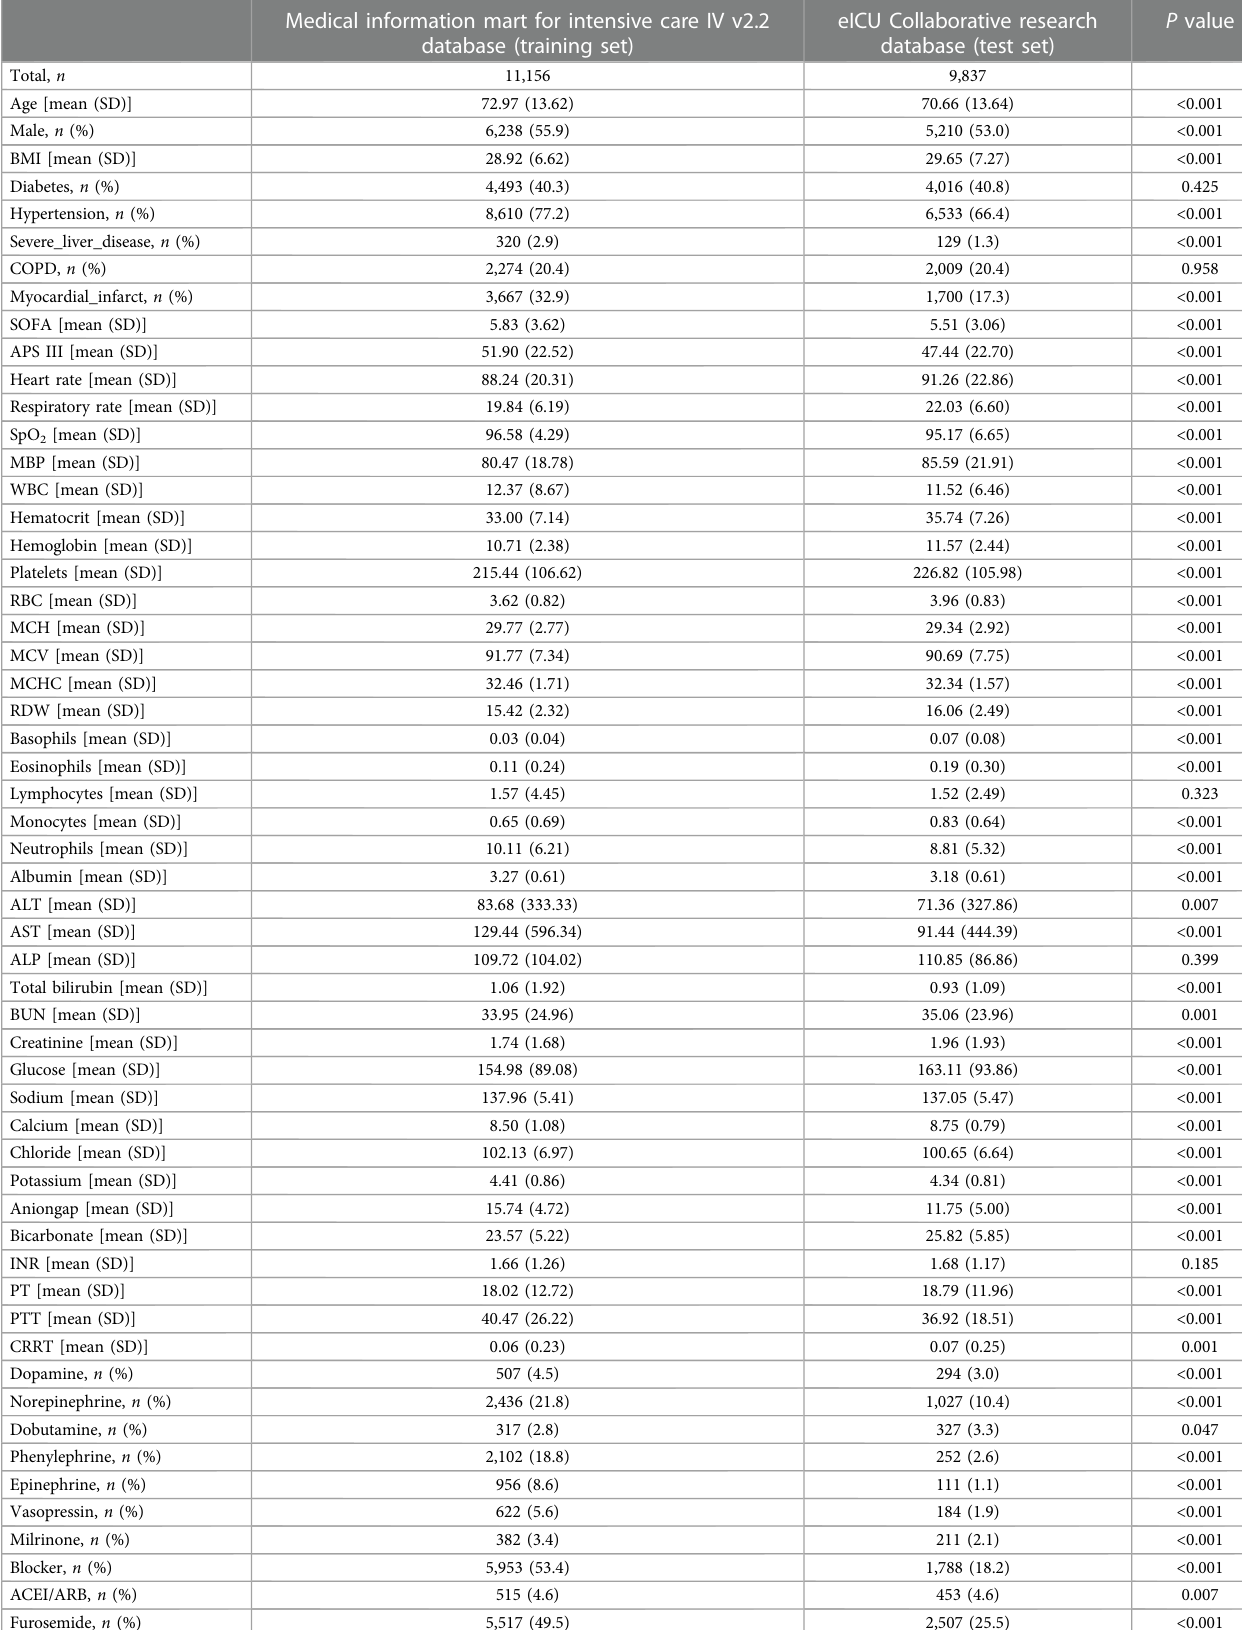
TABLE 1 Clinical data of the study population. Medical information mart for intensive care IV v2.2 database (training